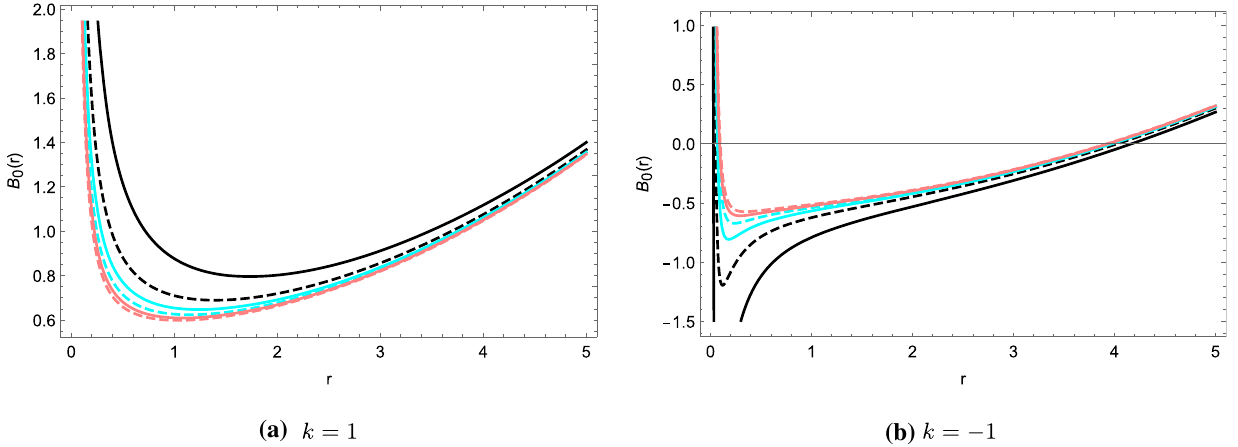
Fig. 3 Metric functions B 0 ( r ) with k = ± 1. The black curve, black dashed curve, cyan curve, cyan dashed curve, pink curve and pink dashed curve correspond to metric functions B 0 ( r ) with c 2 = 1 , 2 , 3 , 4 , 5 , 6 respectively. Other parameters are set as q = 0 . 4 and (cid:3) = − 0 .